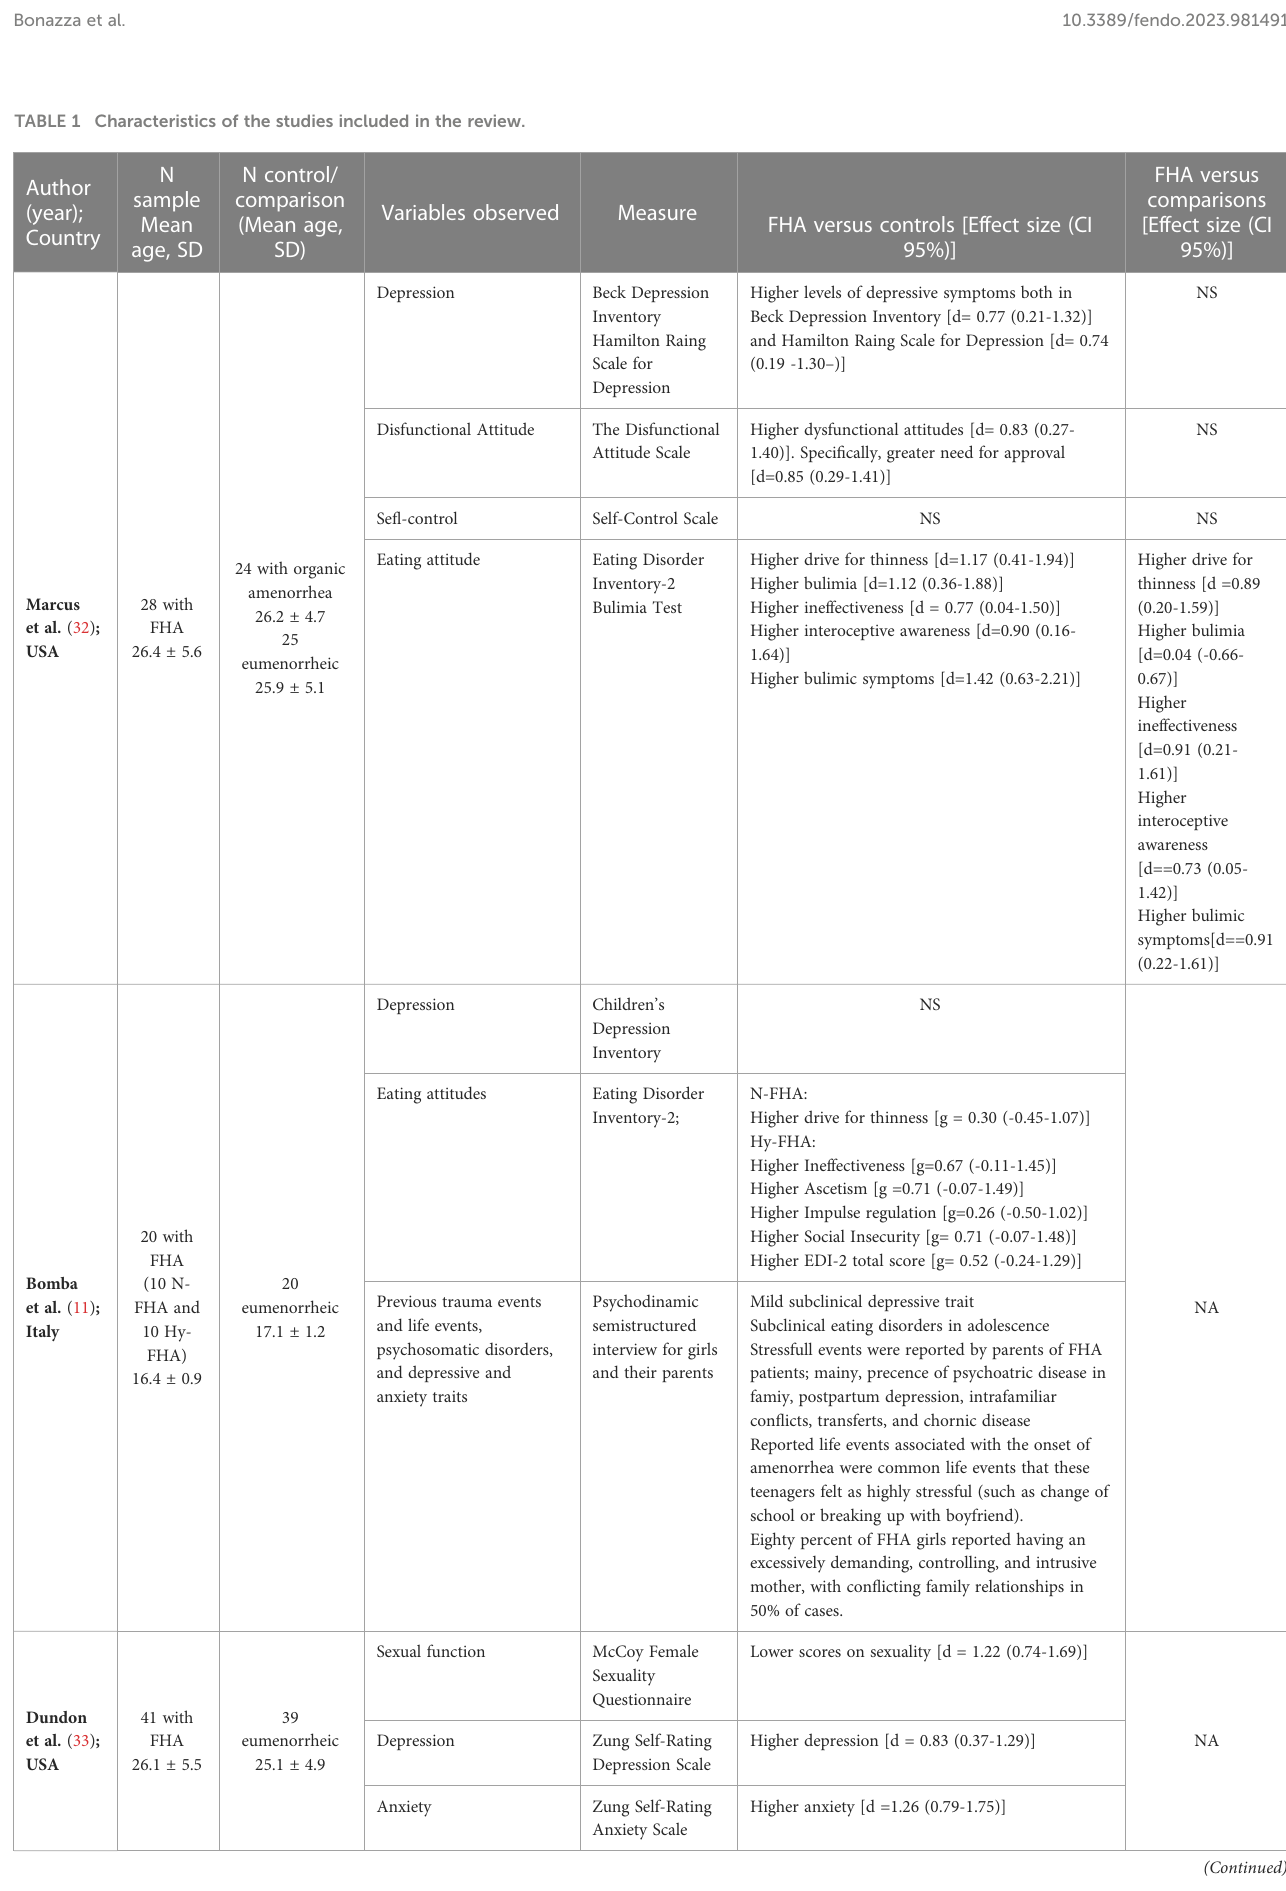
TABLE 1 Characteristics of the studies included in the review.